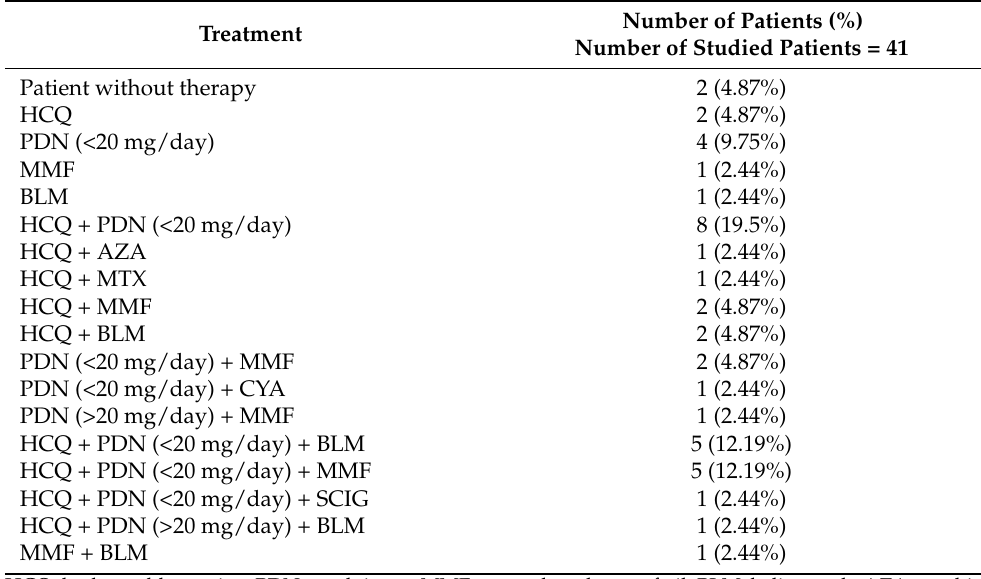
Table 2. Immunosuppressant therapies used in our cohort of patients with systemic lupus erythematosus. Number of Patients (%) Treatment Number of Studied Patients = 41